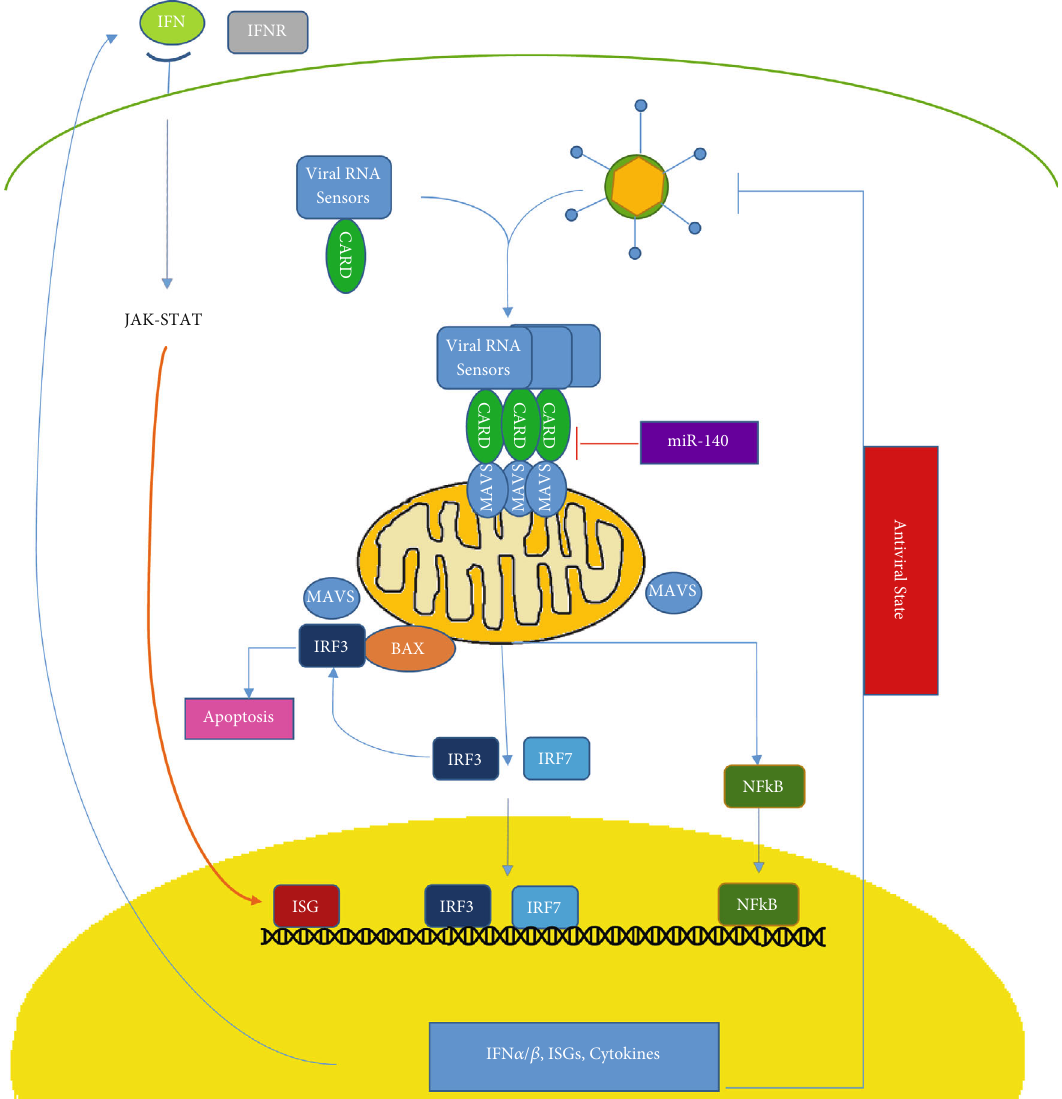
Figure 1: Overview of MAVS signaling pathway as a part of innate immune system defense. After detection of Reovirus by viral RNA sensors, they attach to MAVS protein by CARD domain and activate it. So, MAVS activation leads to secretion of di ff erent cytokines which induces the immune system and results in antiviral state. Moreover, it triggers JAK-STAT signaling pathway which intensi fi es virus elimination by production of di ff erent ISGs. MAVS blocking by miR-140 inhibits all these